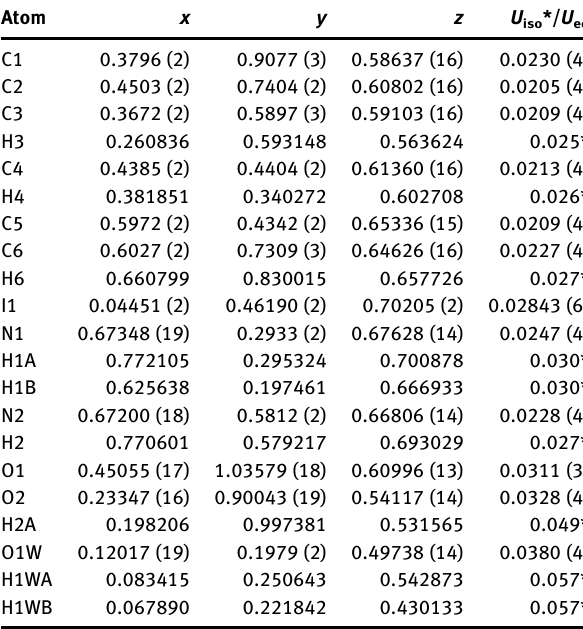
Table  : Fractional atomic coordinates and isotropic or equivalent isotropic displacement parameters (Å 